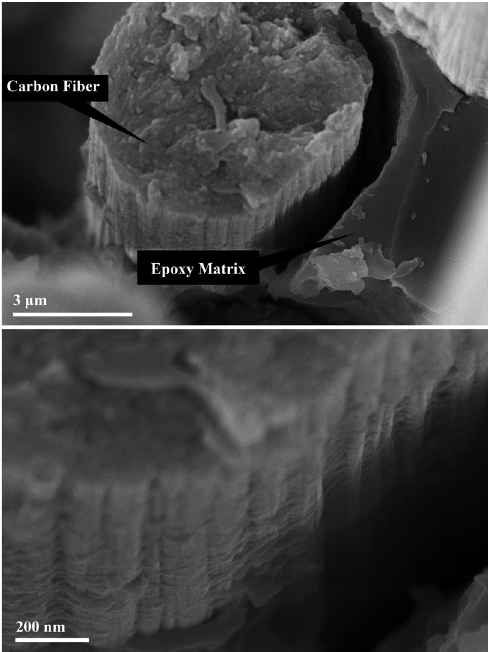
Figure 9: SEM images of the fl exural fractured surfaces of